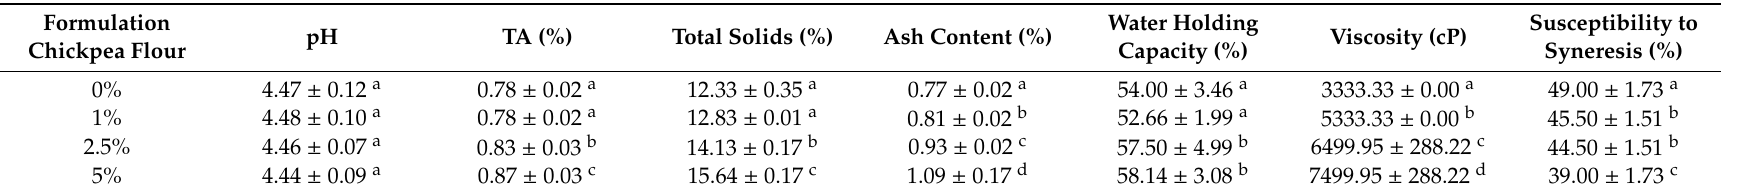
Table 1. Physiochemical properties of probiotic yogurt fortified with chickpea flour during first week of storage at 4 ◦ C ( n = 3, mean ± SD).